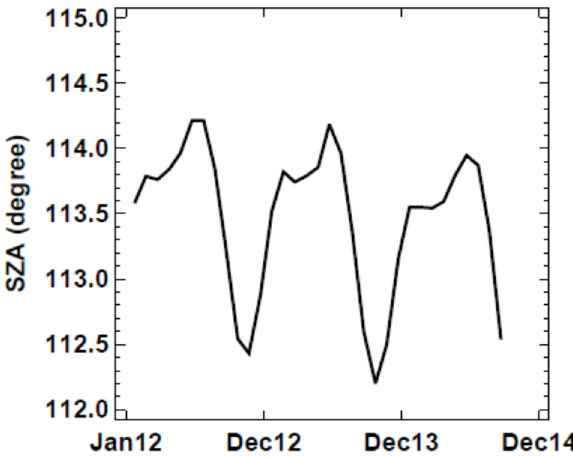
Figure 12. SD onset angle estimated using DNB SV data.